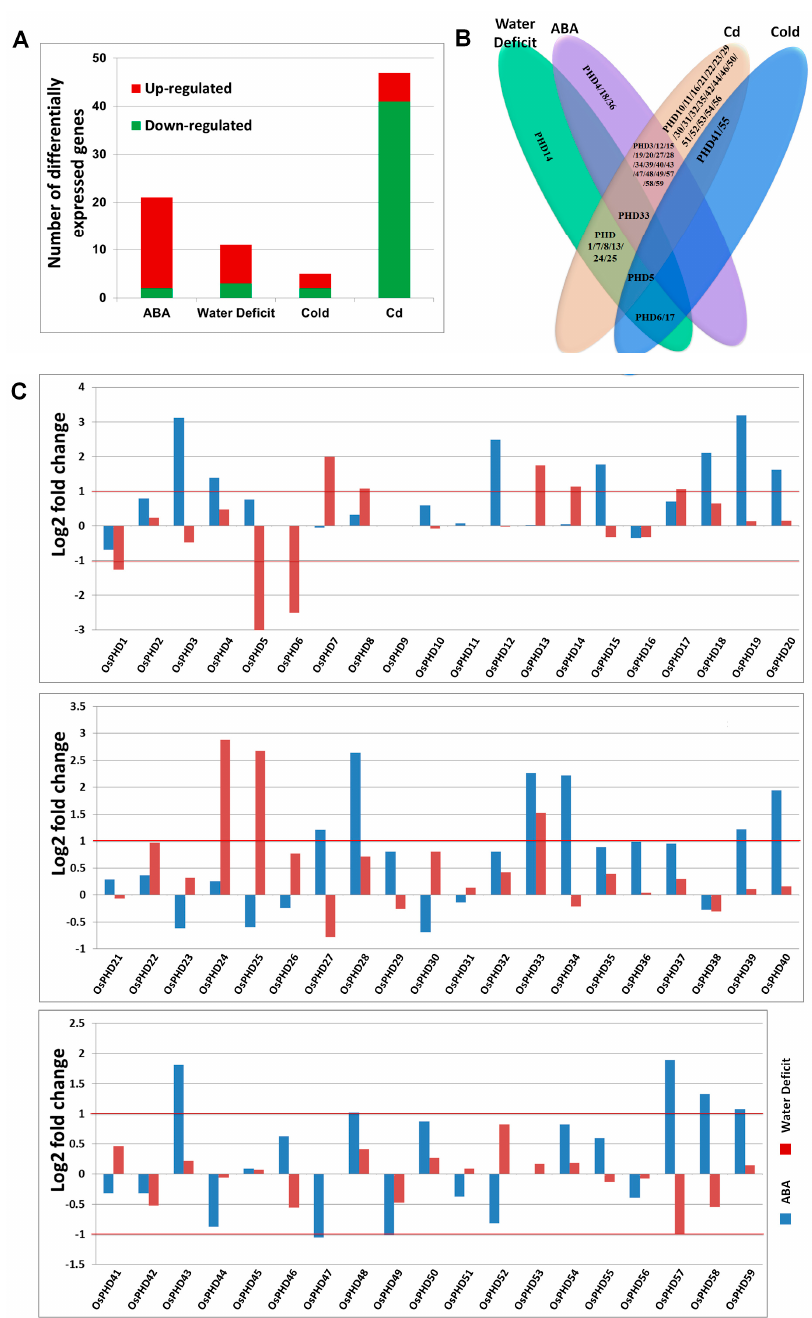
Figure 7. Expression analyses of the rice PHD family genes under different environmental stresses. ( A ) Numbers of differentially expressed OsPHD genes in stress responses. Expression data in different tissues were downloaded from the Rice Expression Profile Database. Compared with the control, genes with |Log2 fold change| > 1 were designated as differentially expressed genes; ( B ) Venn diagram depicting the overlap of differentially expressed genes under different environmental stresses; ( C ) Expression of OsPHDs under ABA and water deficit stresses. The Y-axis represents the log2 of fold changes. The red lines mark the cut-off lines (|Log2 fold change| = 1).